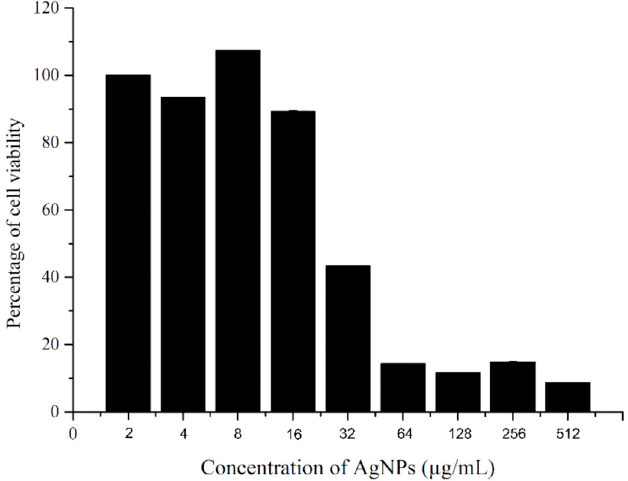
Figure 8. The percentage of dermal fibroblast (NHDF) survival after incubation with the silver nanoparticles solution at a concentration of 2–512 μ g/mL for a period of 24 h.